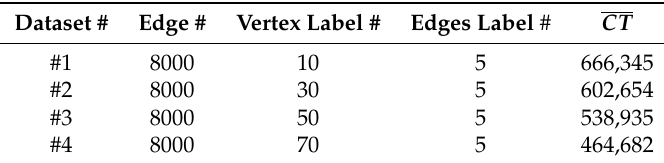
Table 4. Experimental results on the increasing number of vertex labels.